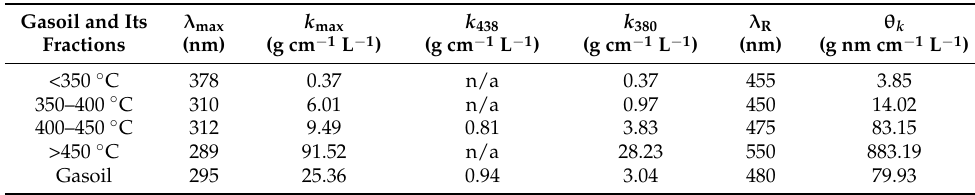
Table 6. Parameters of the broad lines of the absorption spectra of the gasoil and its narrow fraction studied in the work